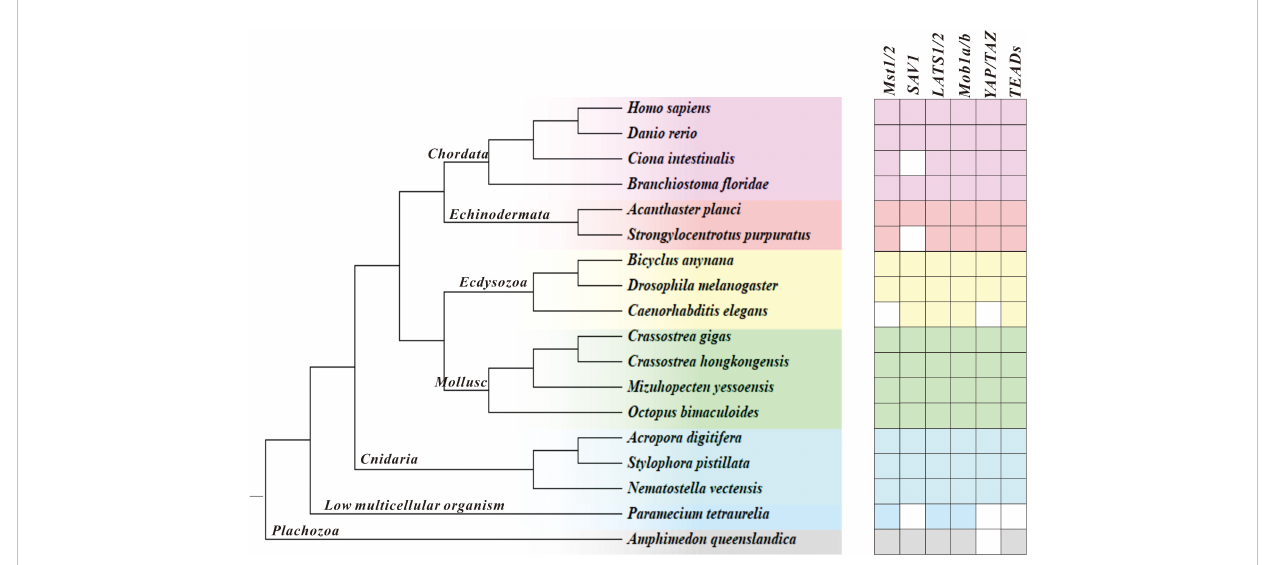
FIGURE 1 Illustration of the Hippo pathway genes in species ranging from A. queenslandica to H. sapiens . Blank represents genes that are not detected, and a pentagram marks C. hongkongensis , which we studied